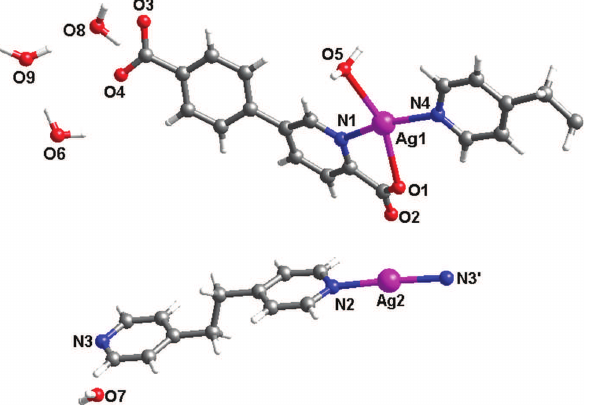
Table 1: Data collection and